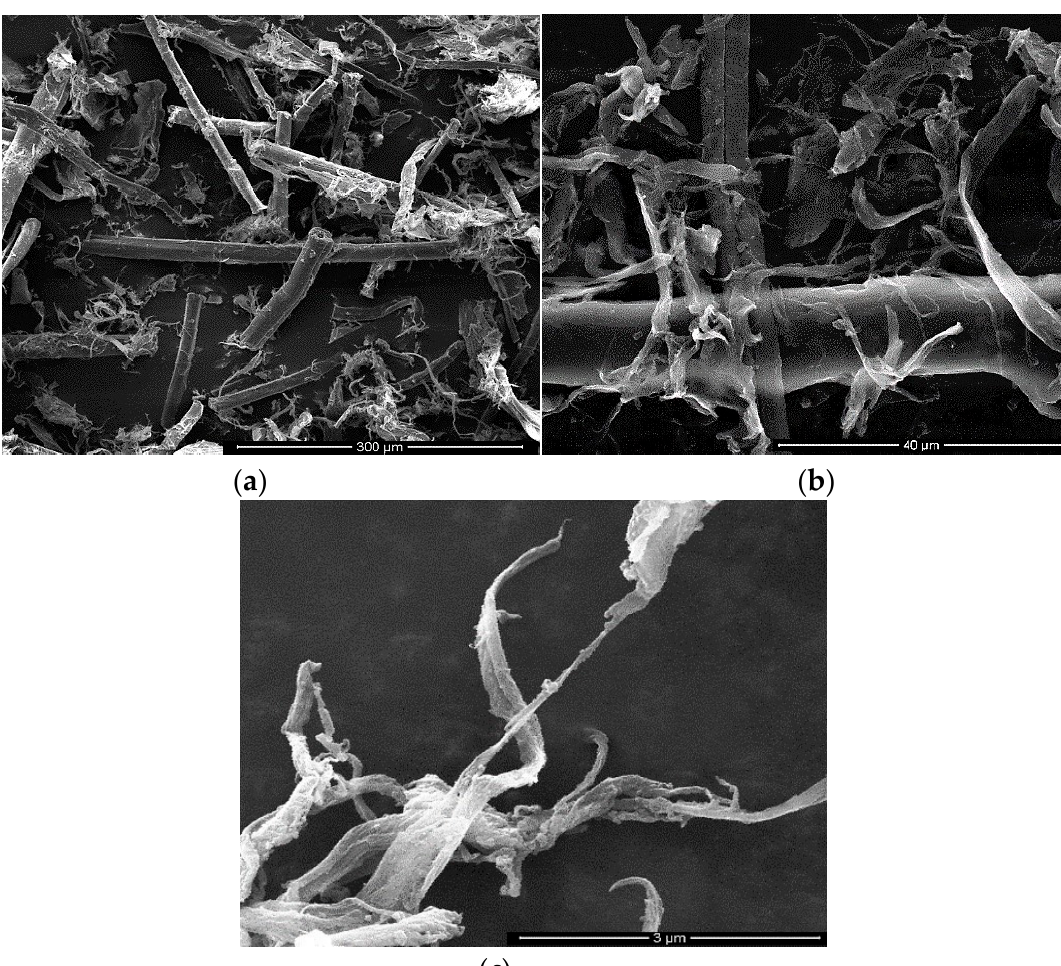
Figure 2. Micrographs of the fibers at different magnifications: ( a ) general overview at 300 µm ( b ) and increasing details at 40 µm ( c ) and 3 µm.